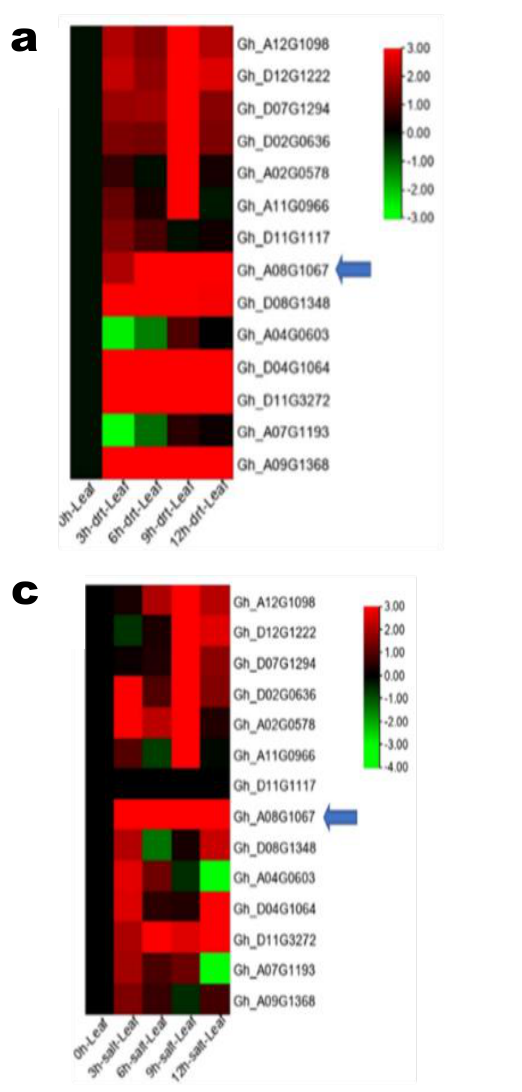
Figure 3. Heat maps showing GhSAMS genes’ differential expression in G. hirsutum under drought and salt stress conditions. RT-qPCR analysis of the expression of GhSAMS genes under drought stress in the leaf ( a ) and roots ( b ). RT-qPCR analysis of the expression of GhSAMS genes under salt stress in the leaf ( c ) and roots ( d ). The higher expression level, the lower expression level, and no expression of the GhSAMS genes at a particular time are depicted by red, green, and black colors,